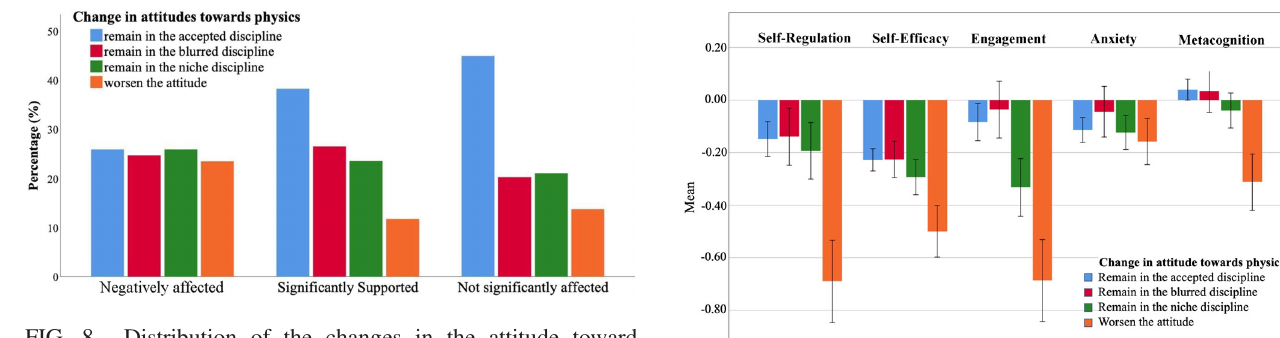
FIG. 8. Distribution of the changes in the attitude toward physics across the SWB clusters. The percentages sum up to 100% for each cluster.